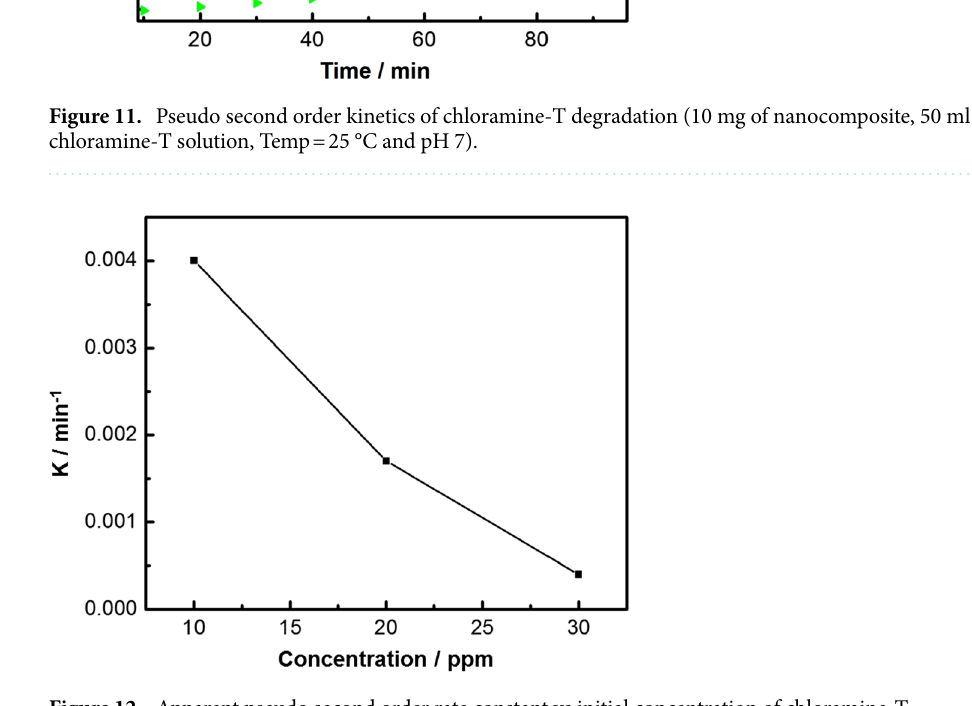
Figure 12. Apparent pseudo second order rate constant vs initial concentration of